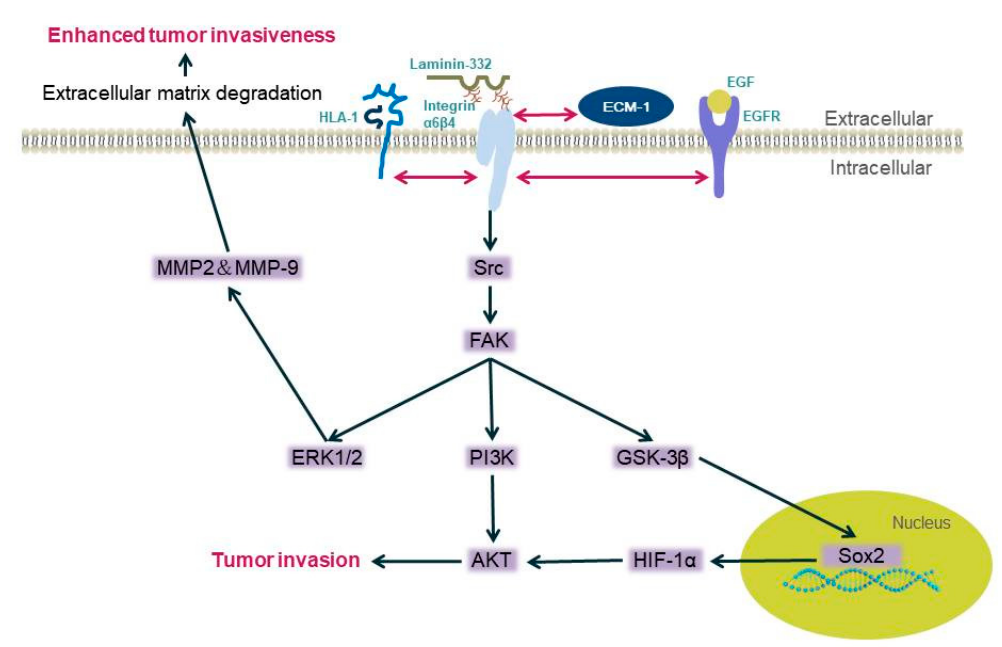
Figure 1. Diagram of the mechanism of integrin β 4 mediating tumor cell invasion. Integrin α 6 β 4 binds with laminin-332, and when the pathways are activated, the binding between laminin and α 6 β 4 is not stable enough, and cells are more likely to be invasive (the double-headed arrow in the figure represents the interaction between the two proteins). The extracellular domain of integrin β 4 has potential glycosylation sites. A report showed that N-glycan deletion on integrin β 4 impaired integrin- β 4-dependent cancer cell